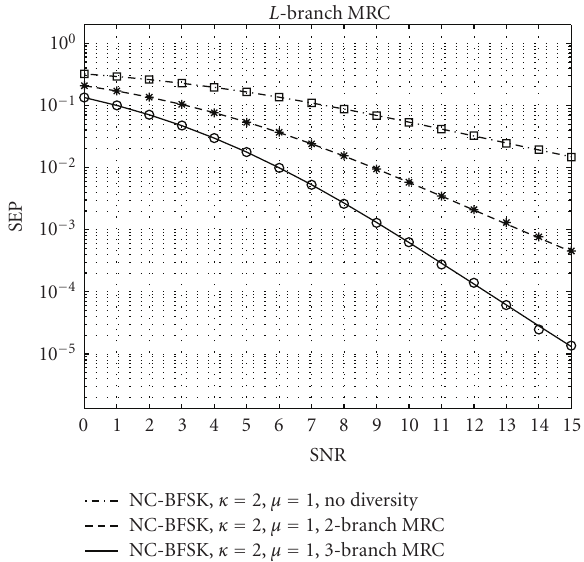
Figure 18: BEP/SEP for noncoherent detection, L = 1, 2,